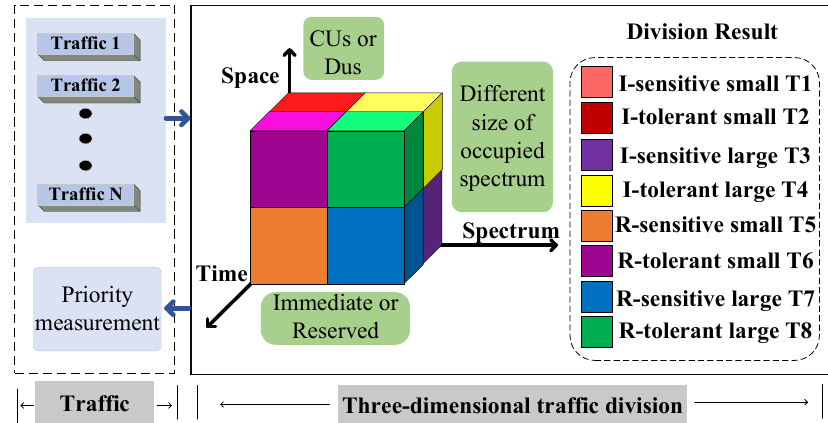
Figure 3. Traffic division with three-dimension parameters for eight types of traffic.